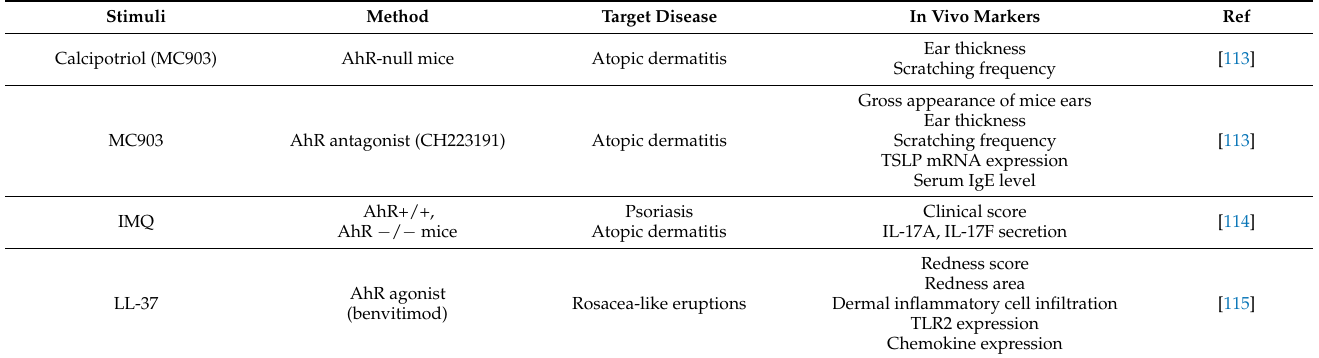
Table 4. Experimental mouse models of AhR-related skin